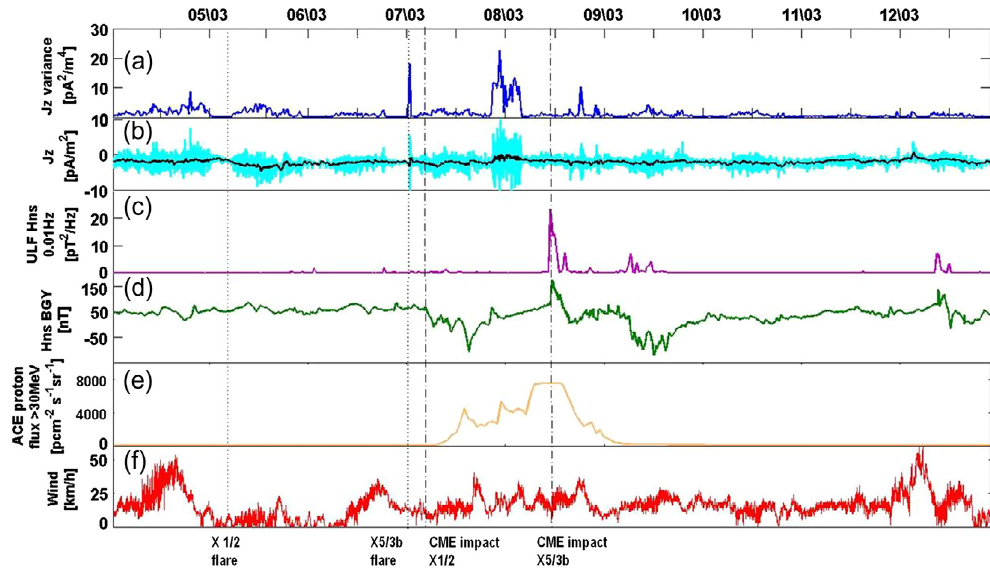
Figure 6. (a–e) The same as Figure 3, for 7–8th March 2012, event. (f) Wind speed.